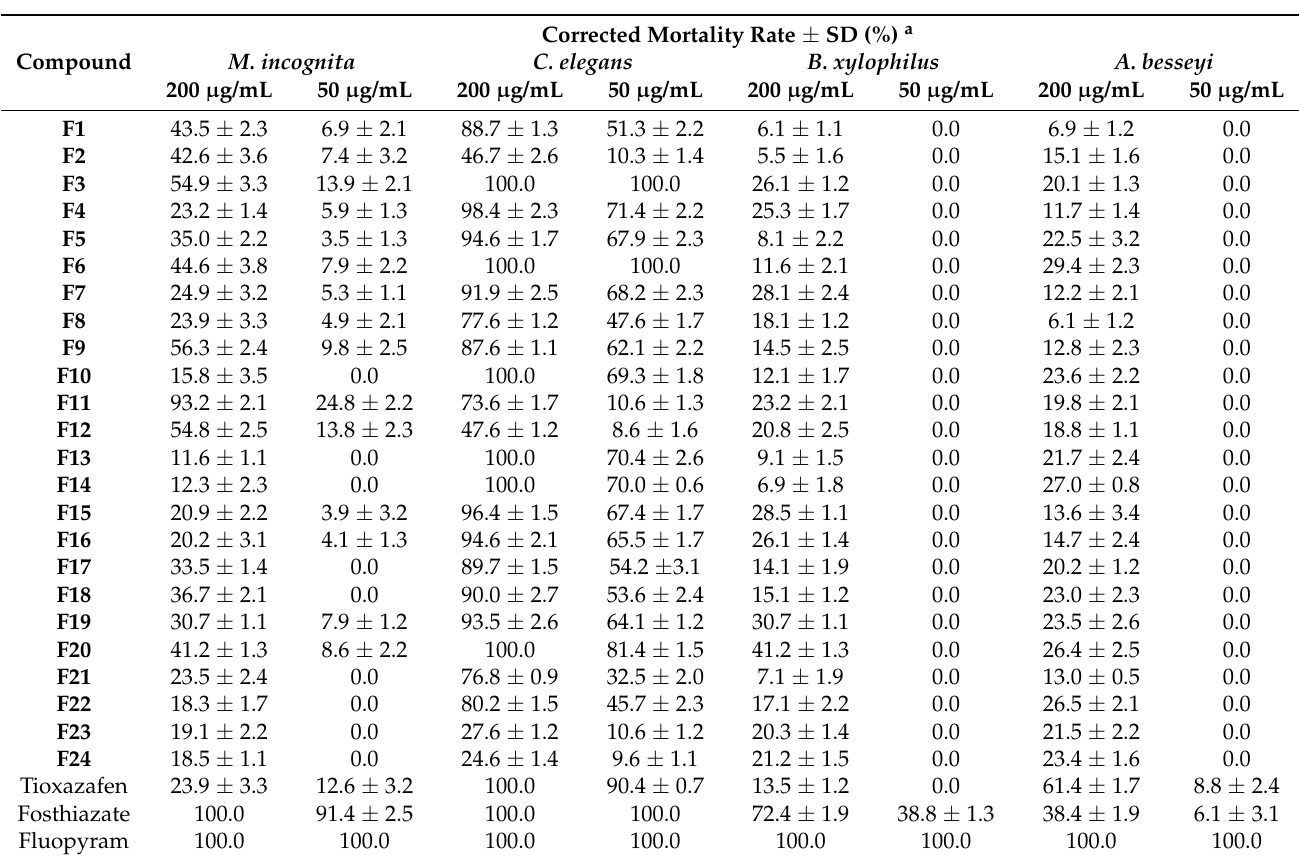
Table 4. In vitro nematicidal activity of compounds F1 – F24